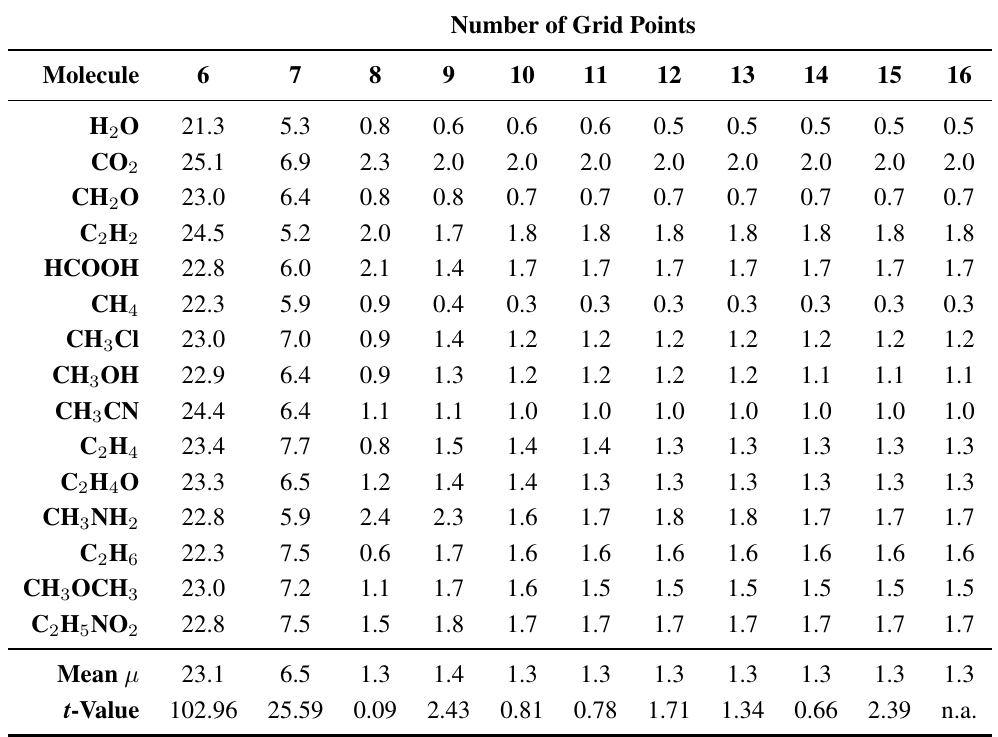
Table 2. Obtained values for µ in %, their arithmetic means and the corresponding t -values according to Equation (12). n.a. means “not